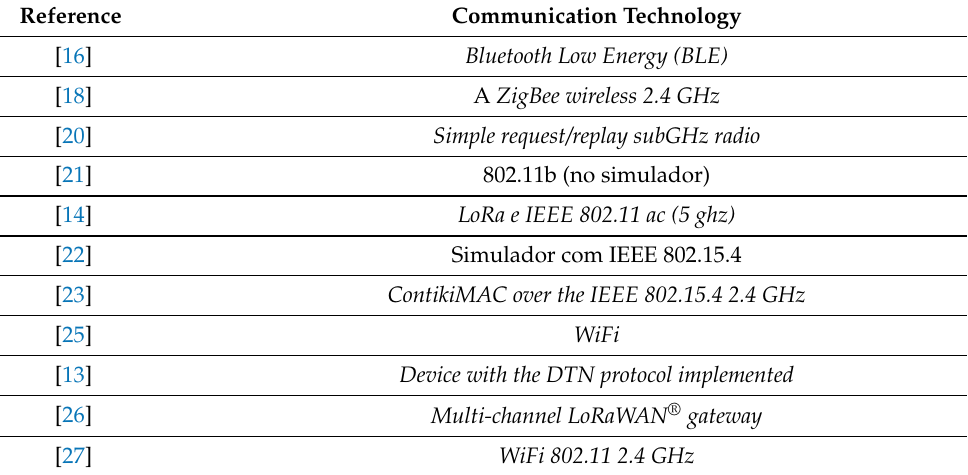
Table 3. Types of